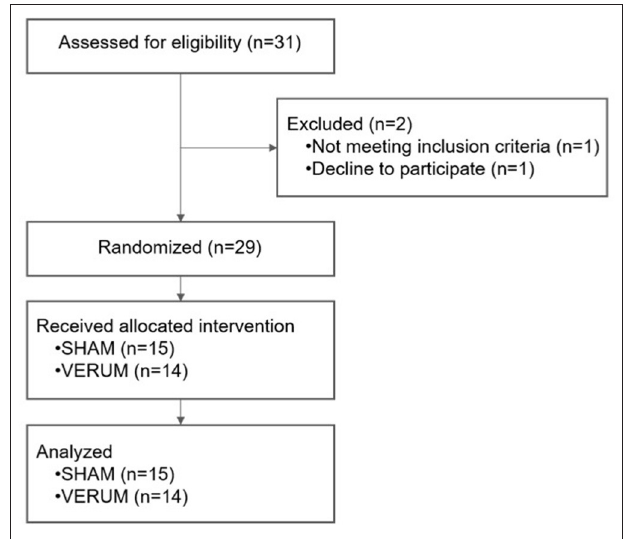
FIGURE 3 | Study flowchart.